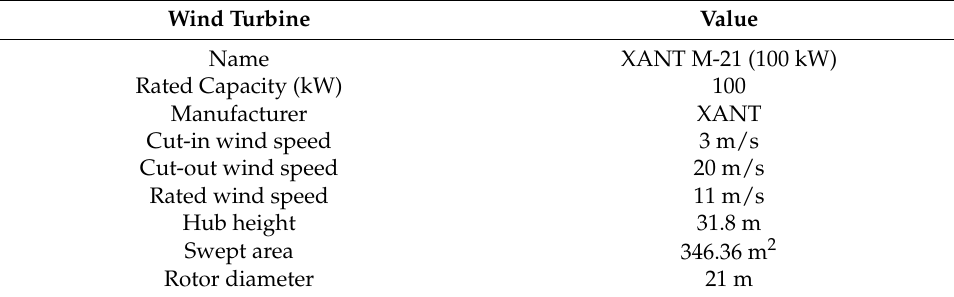
Table 2. Wind turbine details. Adapted from